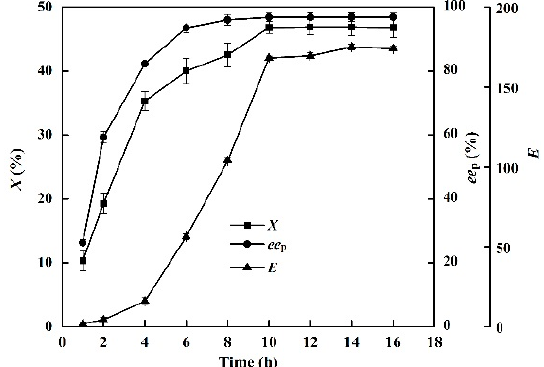
Figure 2. Effect of reaction time (from 0 to 16 h) on the conversion degree, enantiomeric excess of product and enantioselectivity of EST10 using [OmPy][BF 4 ] as a co-solvent in the presence of enzyme EST10 (15 mg/mL) at 75 °C. The concentration of racemic ibuprofen ethyl ester was 2.5 mg/mL. The values are means of three independent experiments.